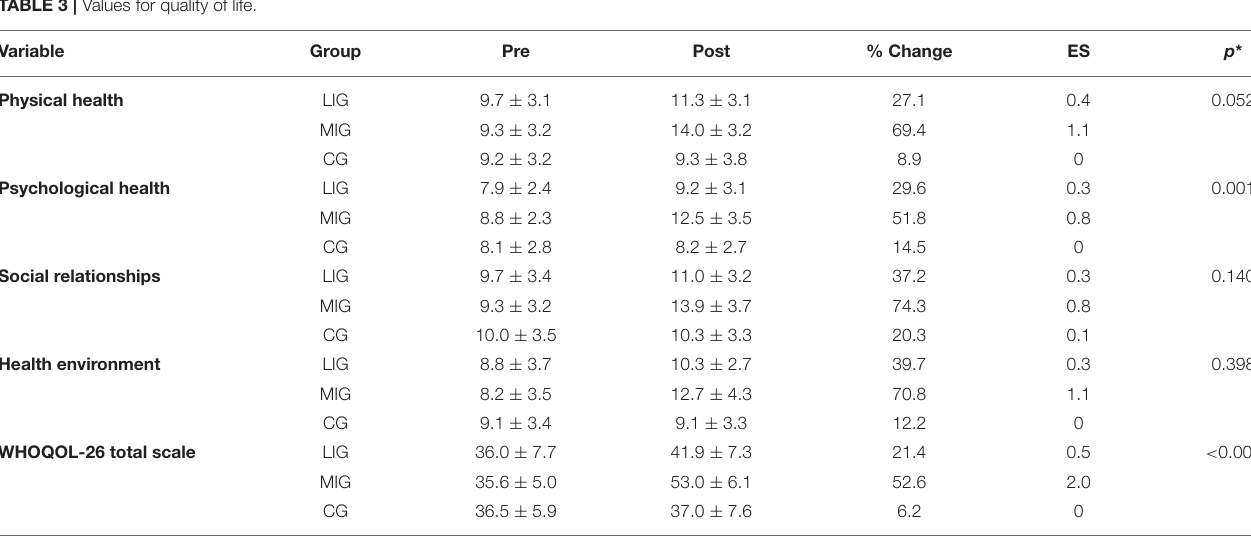
TABLE 3 | Values for quality of